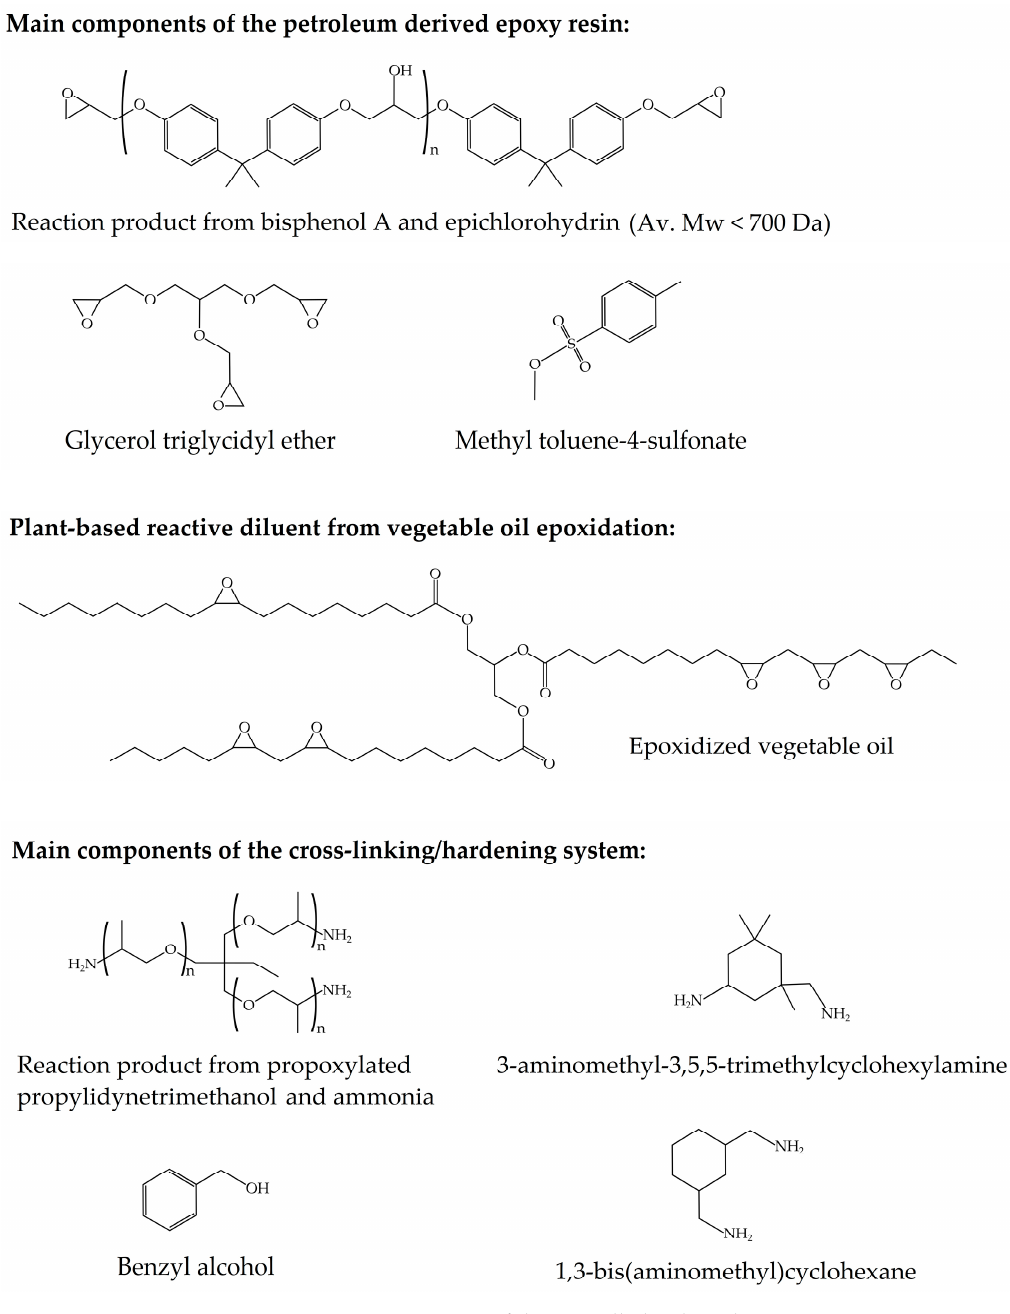
Figure 1. Main reactive components of the partially bio-based epoxy system.